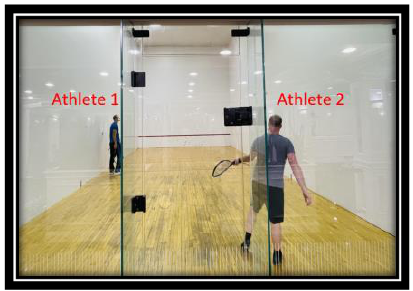
Figure 19. Collecting Squash players Earlobe Data: Observation Set F.